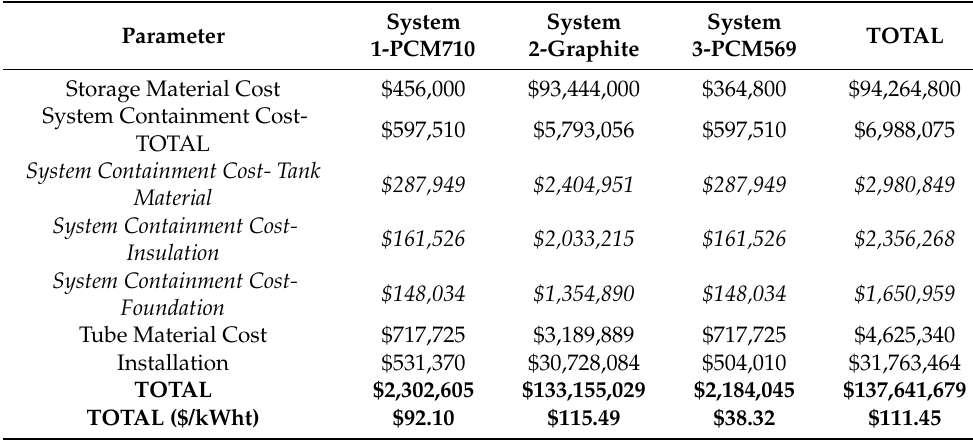
Table 6. Summary of Thermal Storage System